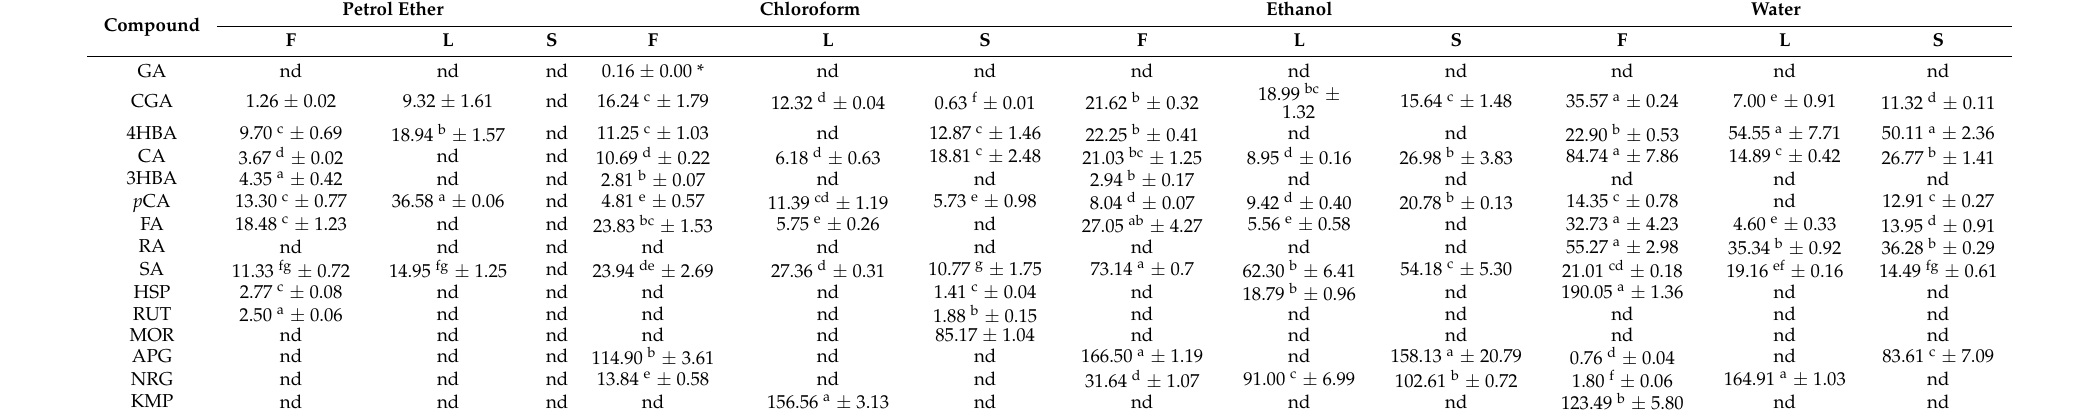
Table 1. Phenolic composition ( µ mol/g) of extracts of aerial parts of Gentiana lutea